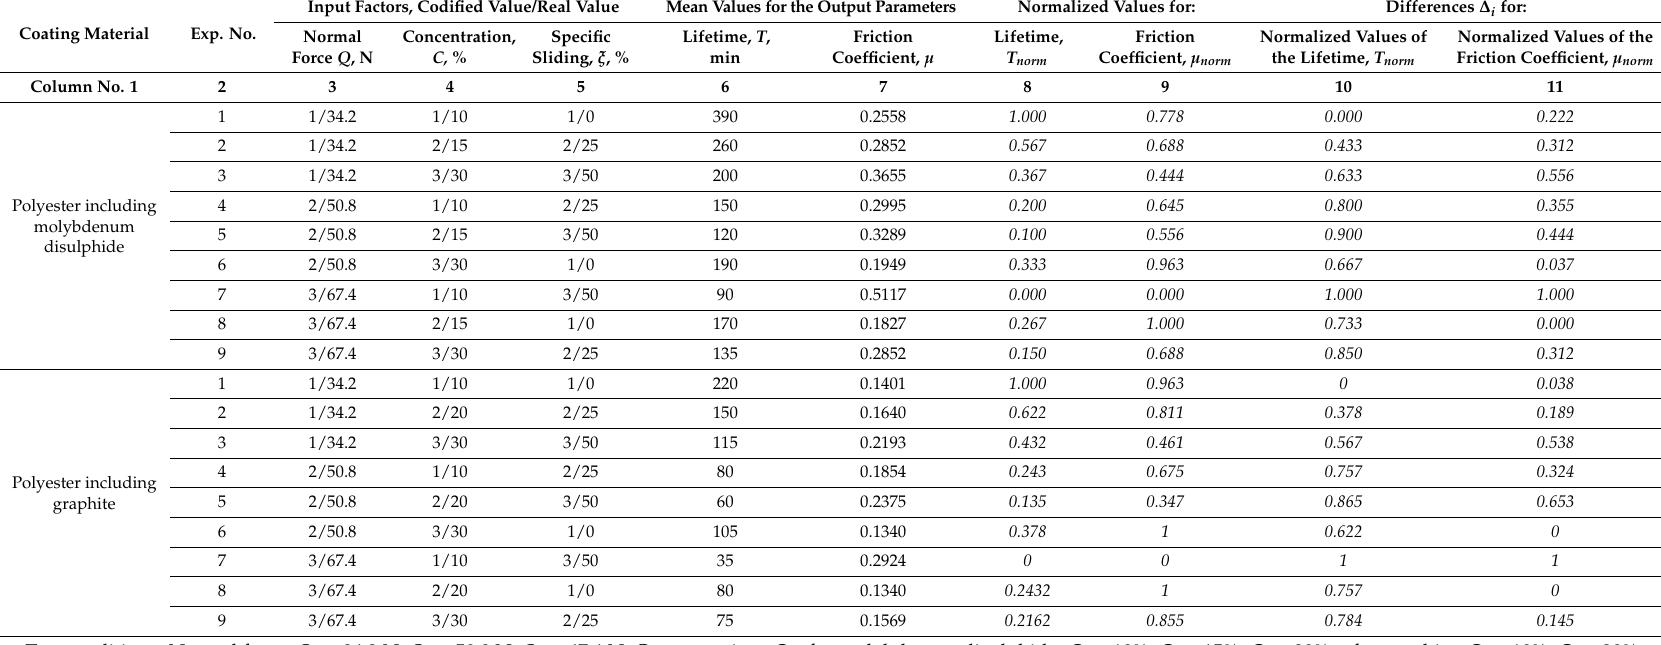
Table 1. Experimental conditions and